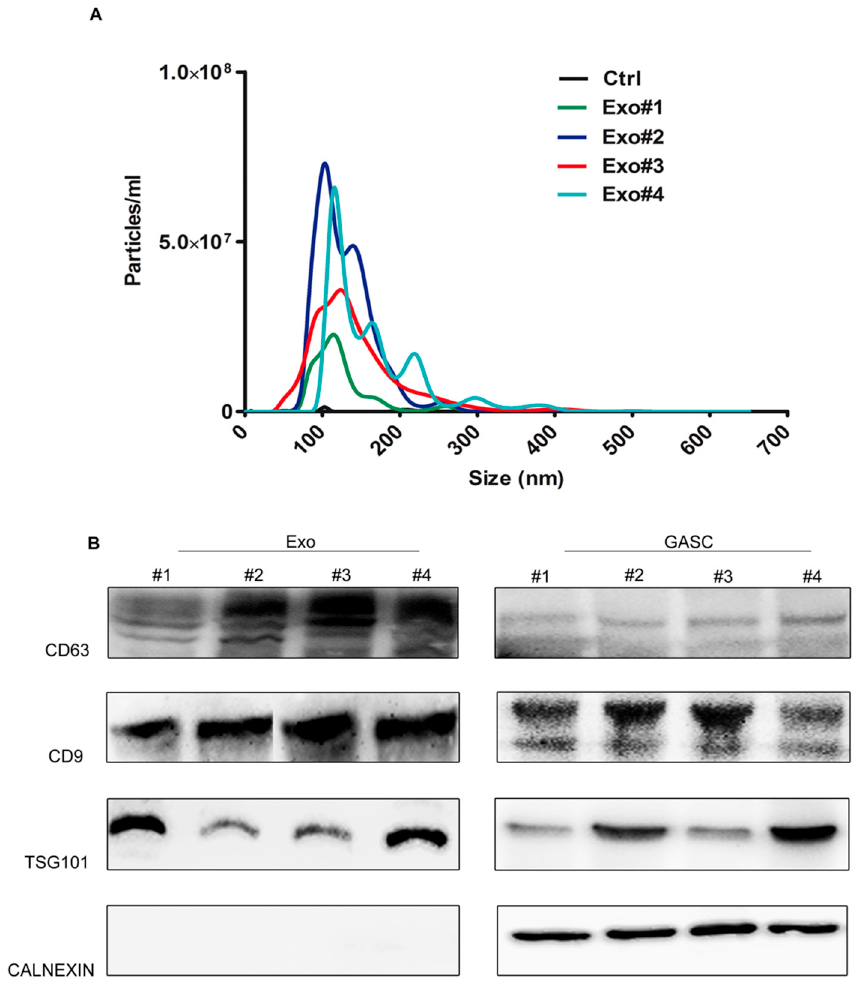
Figure 1. Characterisation of glioma associated stem cell (GASC)-derived exosomes. ( A ) Representative graphs of nanoparticle tracking analysis (NTA) on a preparation obtained from a nonconditioned supernatant (Ctrl) and on exosomes (Exo) isolated from supernatants conditioned for 48 h by 4 GASC cell populations (Exo#1, Exo#2, Exo#3 and Exo#4). ( B ) Western Blotting for exosome-specific markers (tetraspanins CD63, CD9 and TSG-101) and for cell endoplasmic reticulum marker (calnexin) on